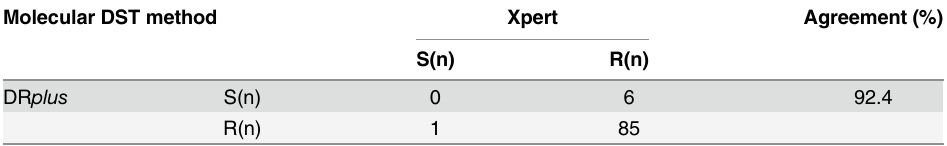
Table 2. Comparison of Xpert and DR plus assay for detection of RIF susceptibility, n = 92.